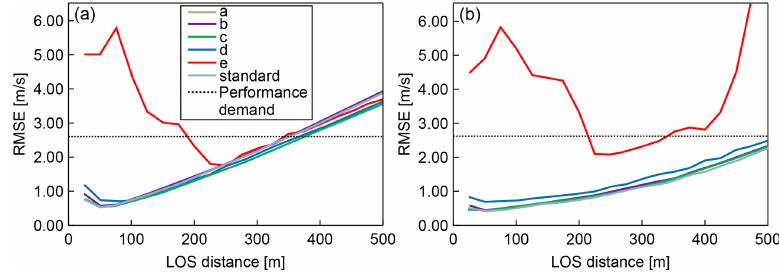
Figure 18. Statistical estimation performance (root mean square error) for LOS wind velocities including error and noise under six atmospheric-condition scenarios (a–e and standard) (assuming ideal vortex model). (a) Simple vector conversion; (b) proposed method.